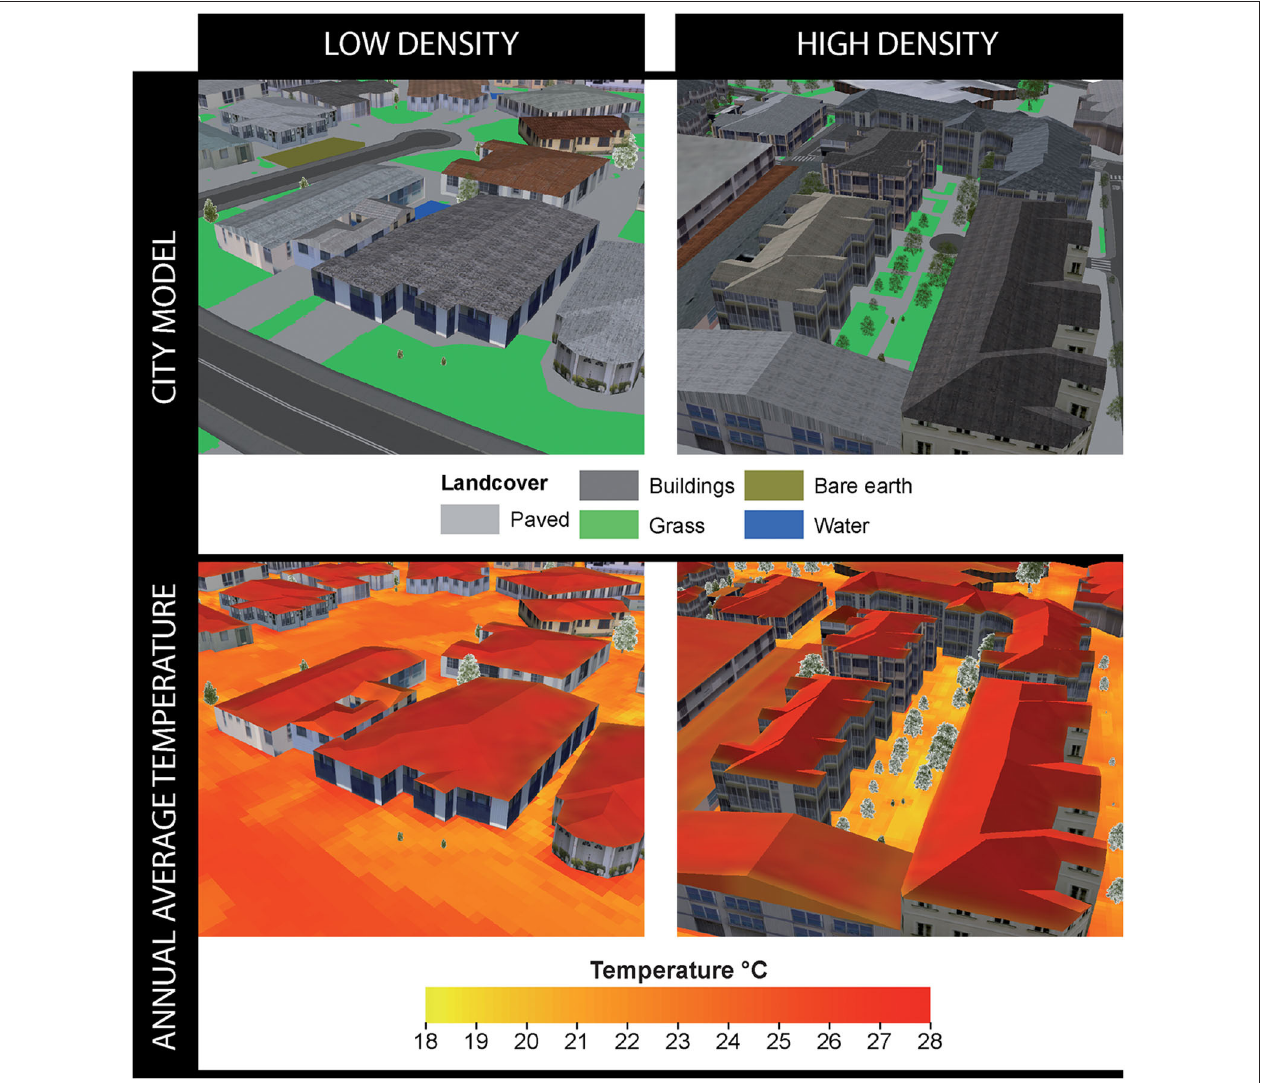
FIGURE 2 | Three-dimensional city models (top row) and average annual mean radiant temperature ( T mrt ) overlays (bottom row) for subsets of two SA1 locations representing low-density (cul-de-sac in Currambine) and high-density (infill site in Subiaco) developments. Two-dimensional renditions for complete SA1 coverage are presented in Figure 3